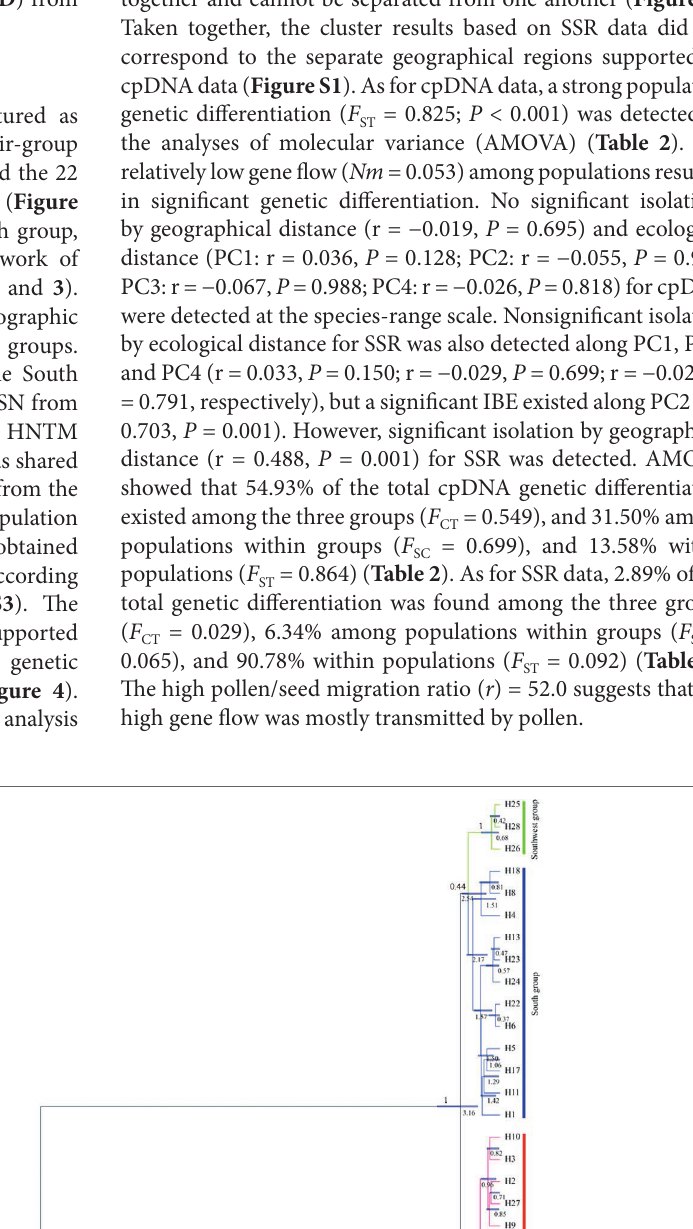
Frontiers in Genetics |